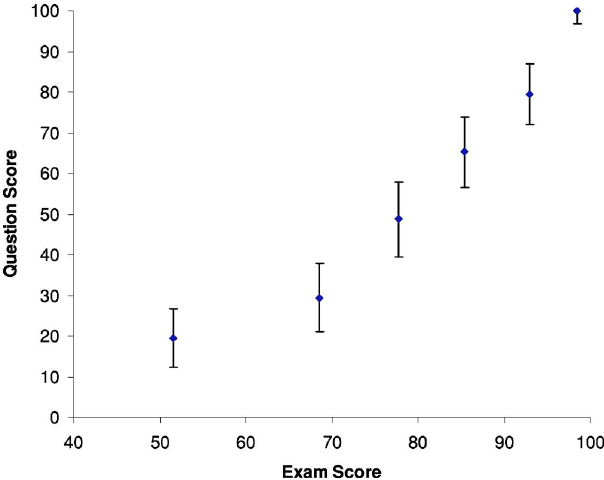
FIG. 5. (cid:1) Color (cid:2) This is a discrimination plot for question 23 on the first final exam shown in the Appendix. Each data point repre- sents a bin of approximately 50 students. The exam score for each bin is the average for that bin on the remaining questions on the